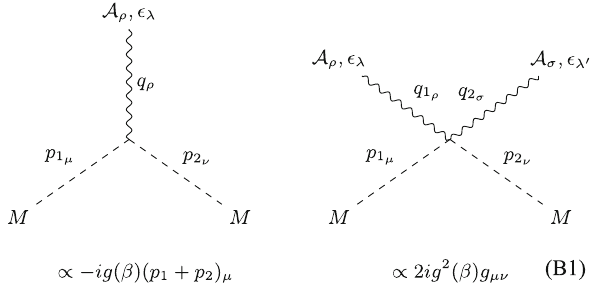
Fig. 29 In SQED, spin-0 scalar bosons (dashed lines) interact with photons (wavy lines) according to the vertices in the figure. The corre- sponding Feynman rules are given in